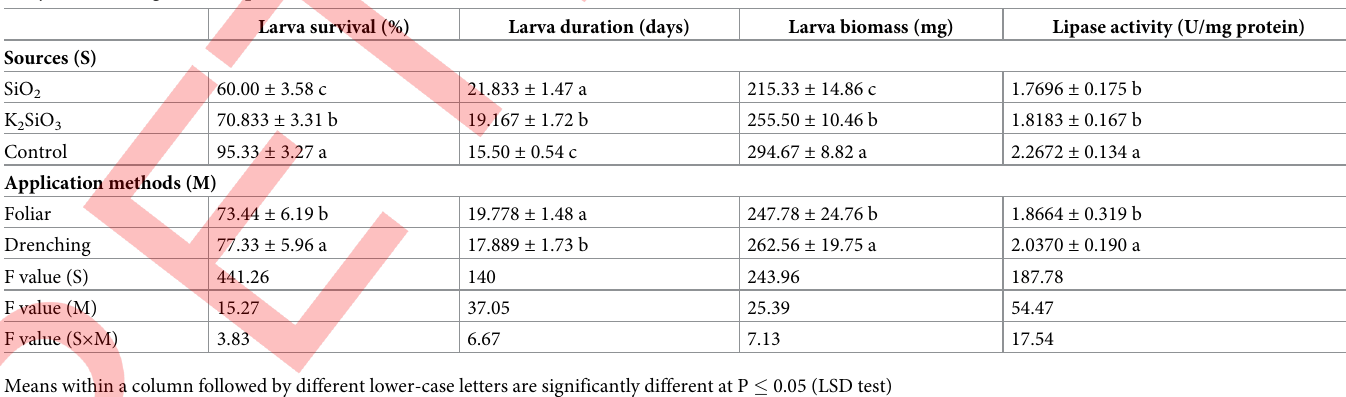
The lowest biomass (202 ± 2.65 mg) was recorded in larvae fed on plants treated with foliar Table 1. Effect of silicon sources and silicon application methods on larva survival %, larva duration (days), biomass(mg), and lipase activity (U/mg protein) of fall armyworm feeding on maize plants. Larva survival (%) Larva duration (days) Larva biomass (mg) Lipase activity (U/mg protein)